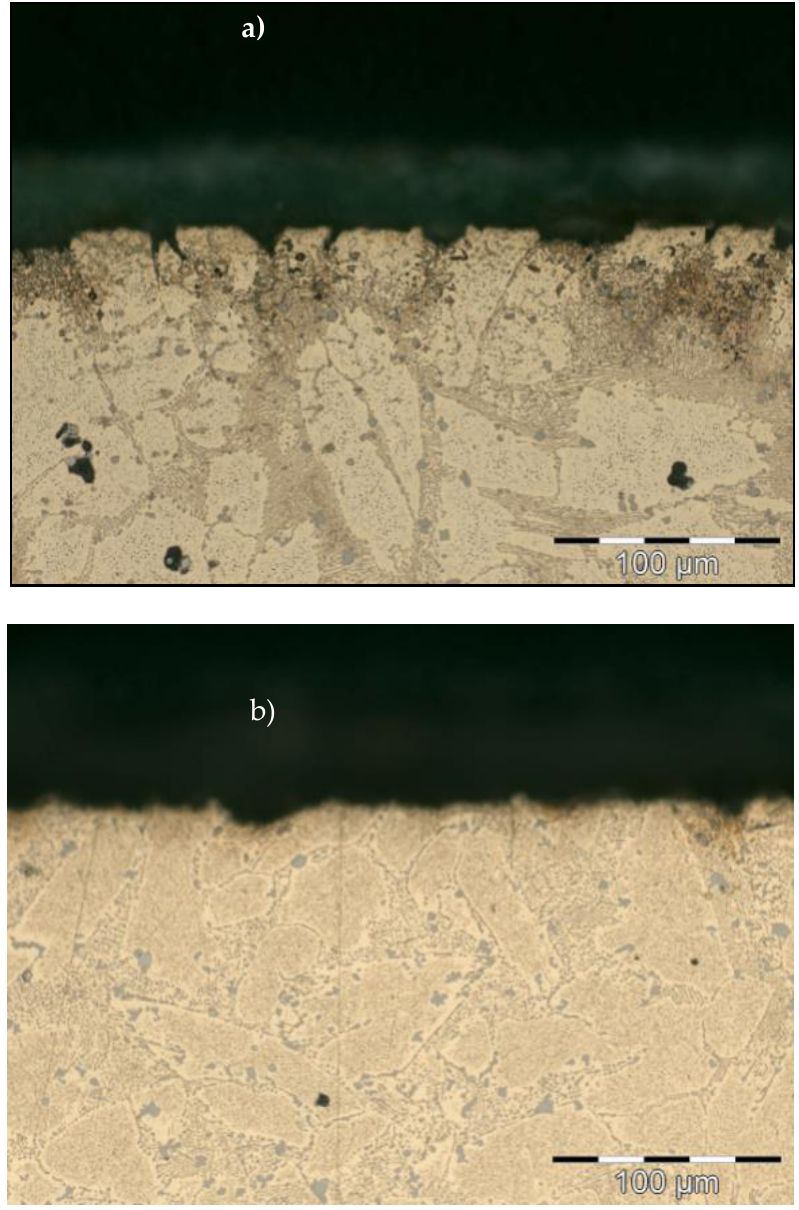
Figure 2. Cross section view after the dealloying test for ( a ) “as-cast” samples and ( b ) annealed samples. After 24 h of immersion, intergranular corrosion is distinctly developed in both samples. As it can be observed in Figure 2a,b, the cross sections show that the attack is more intense, both in terms of pit depth and density of pits for the B (as-cast) samples than for the BR (annealed) samples. Moreover, the corrosion process in the BR (annealed) sample (Figure 3b) has just contoured the grains, while the attack has progressed beneath the surface for the B (as-cast) sample (Figure 3a). average pit depth. The average corrosion depths of both materials obtained from the cross section images (Figure 2a,b) are shown in Table